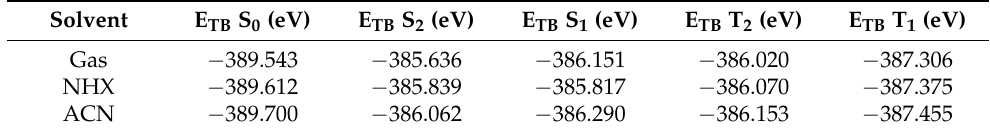
Figure 6. A comparison between the optimized molecular structures of the 1 CT (=S 1 ) states in ACN (in brown) in NHX (in blue) and in the gas-phase (in pink). Note that the molecular structure of 1 CT is strongly influenced by a polar solvent (CAMY-B3LYP/TZP). Table 3. The total bonding energies are calculated at the optimized geometries of the states with the TZ2P basis and the CAMY-B3LYP functional with the default parameters for range separation.